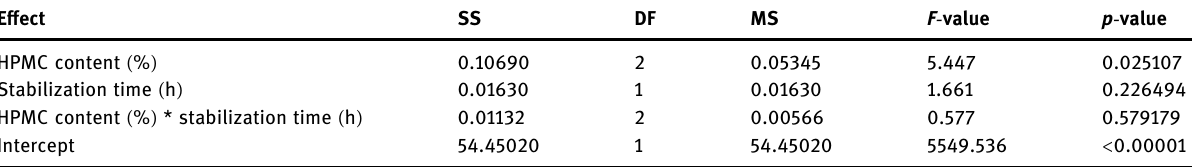
Table 12: Analysis of variance ( ANOVA ) for tensile strength in fl exion results of mortars with 48 and 72 h of stabilization E ff ect SS DF MS HPMC content ( % )